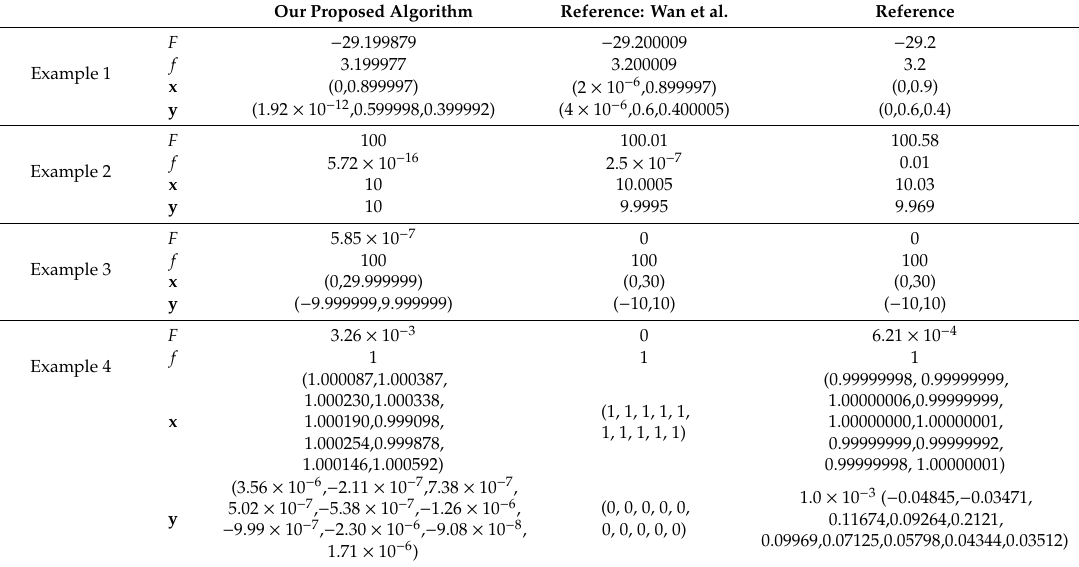
Table 4. Comparison of the solutions by the proposed algorithm with those in related